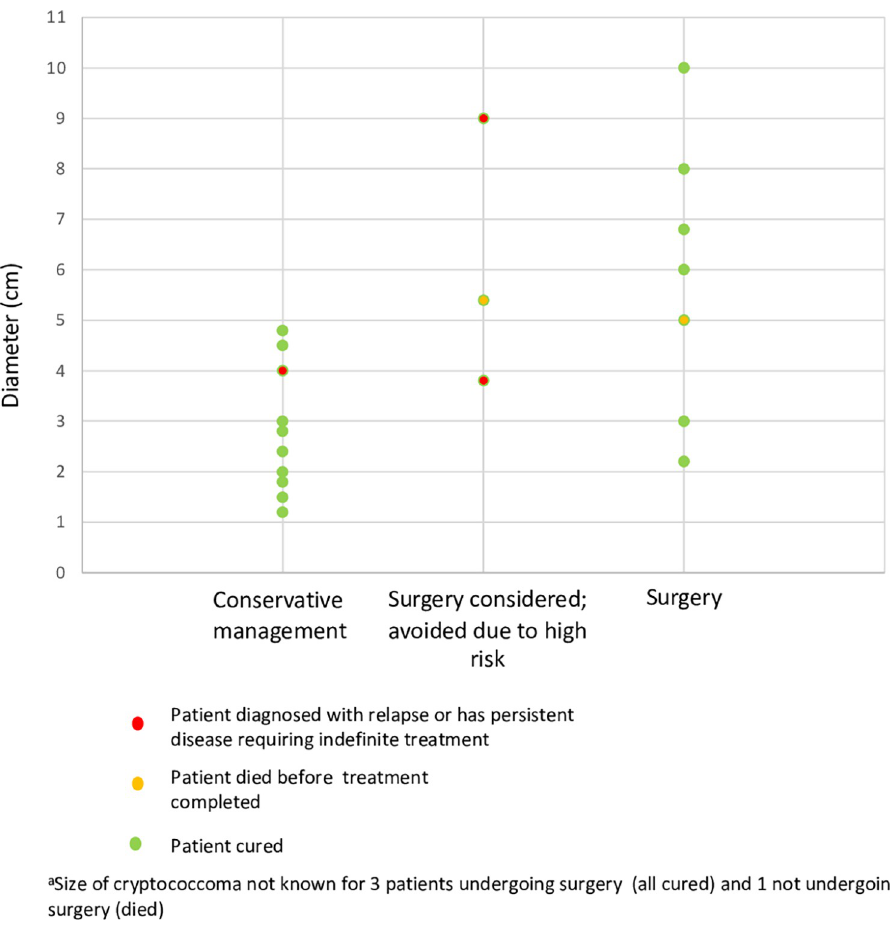
Fig 4. Surgical or conservative management vs diameter of largest pulmonary cryptococcoma and outcome a